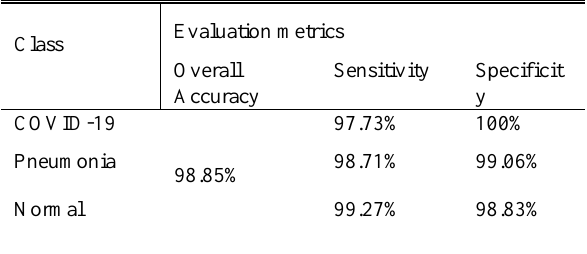
Table 4. The performance results of the three-class classification (COVID-19 vs. Normal vs. Pneumonia).